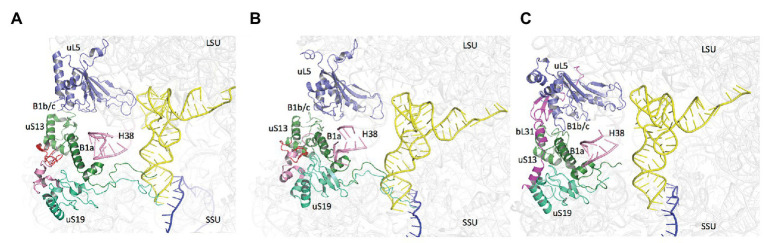
Domain specificities of uS13 and uS19 cores. The three panels show the B1a-B1b/c bridge. (A) Archaeal case. The view is a composite using the SSU from PDB 6SWC (Coureux et al., 2020) and the LSU from PDB 4V6U (Armache et al., 2013). (B) Structure of human ribosome from PDB 6Y0G (Bhaskar et al., 2020). (C) Structure of Escherichia coli ribosome from PDB 5AFI (Fischer et al., 2015). The views show that archaeal and eukaryotic uS13 and uS19 have specific extensions (in red and pink, respectively) that contribute to the intersubunit bridge. Bacteria have instead a specific ribosomal protein bL31.